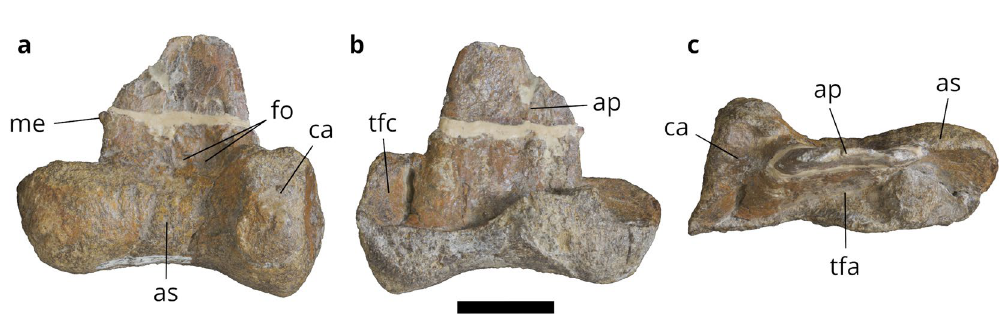
Figure 3. Comparisons of noasaurid cervical vertebrae. ( a ) LRF 3050.AR and ( b ) MACN-PV 622 (modified from Agnolín and Martinelli 53 ) both in ventral view. Abbreviations as in Fig. 2 and prz, prezygapophyses. Scale bars equal 10 mm.